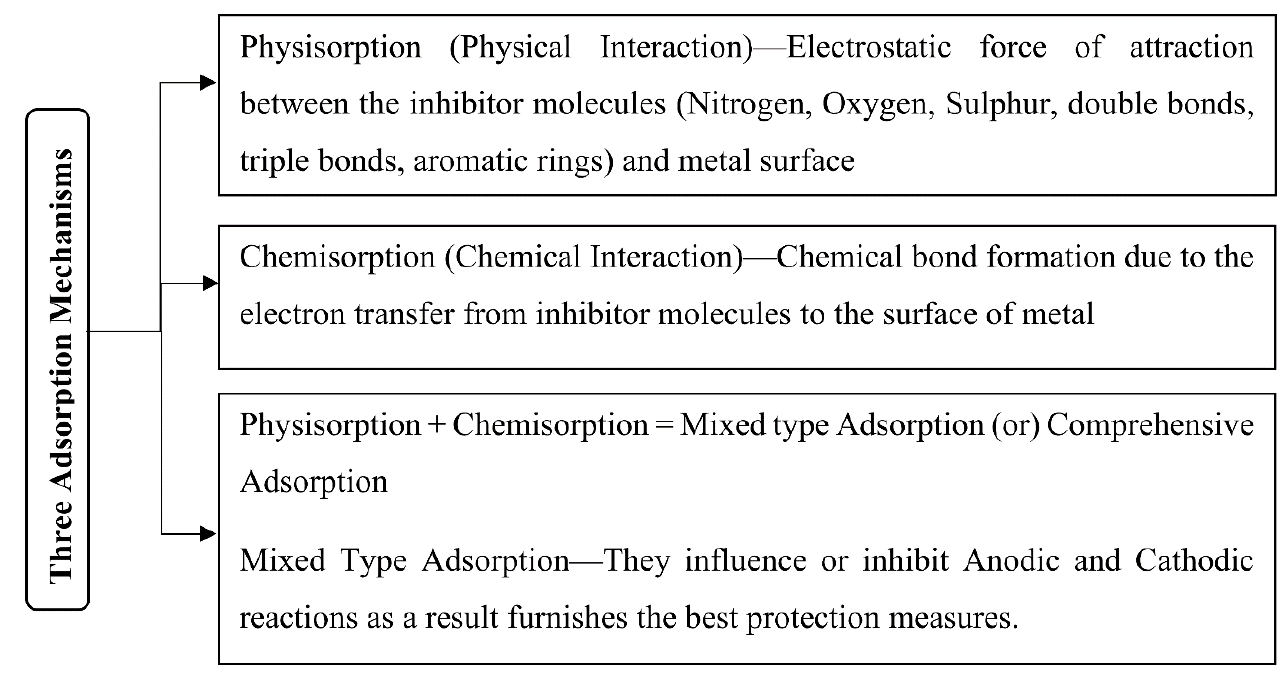
Figure 9. Mechanisms of Adsorption.